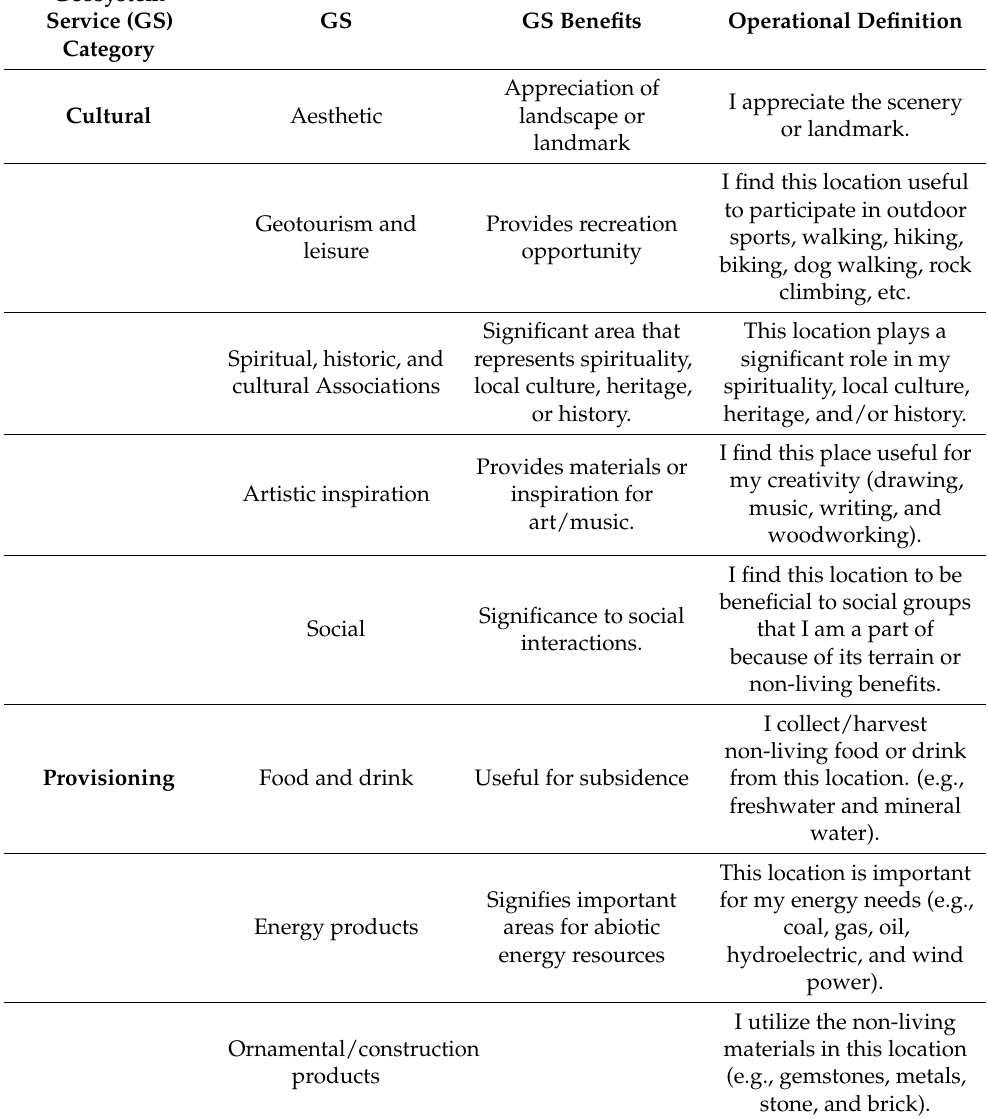
Table 2. Geosystem services marker